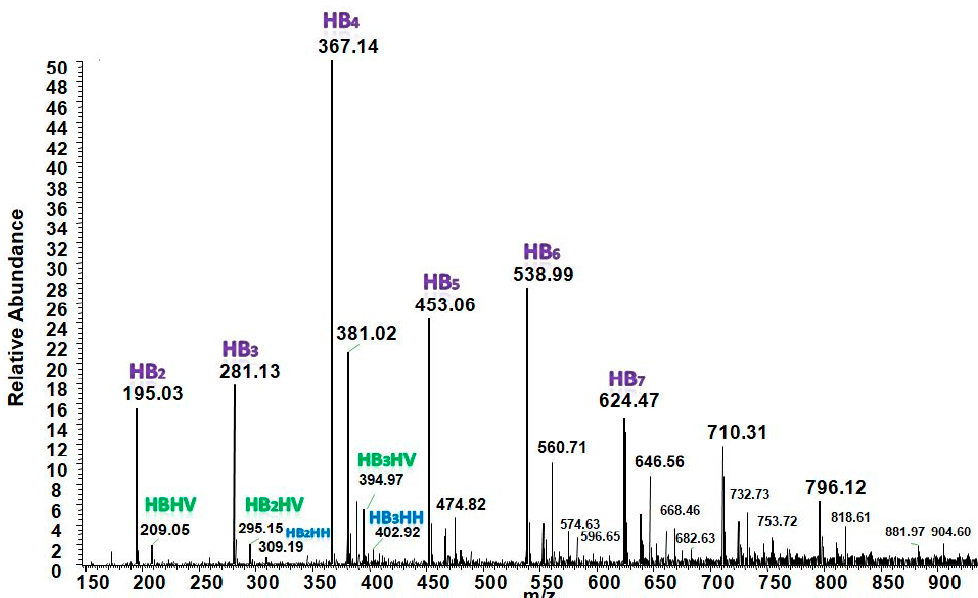
Figure 10. ESI-MS (positive–ion mode) of the water-soluble fraction of PHA oligomers formed after the partial thermal degradation of the PHA-PP2 sample.